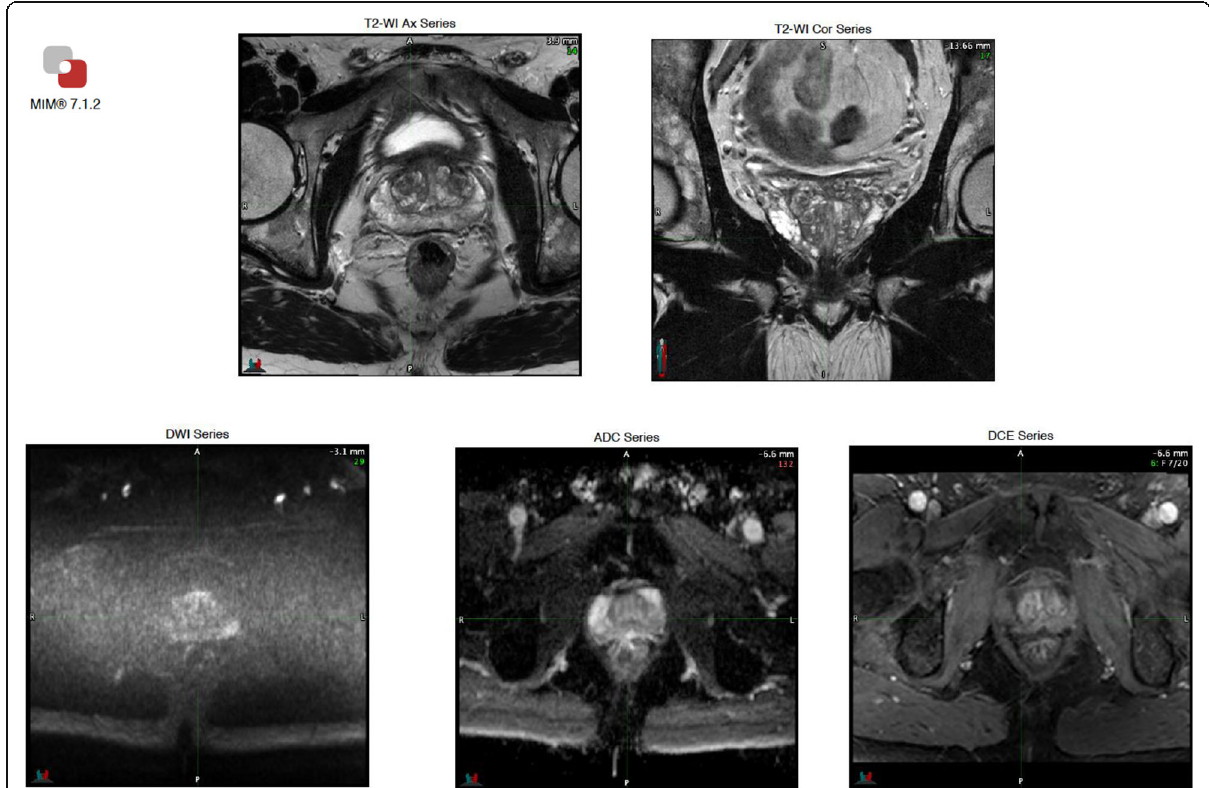
Fig. 4 Structured report obtained using the dedicated PI-QUAL software